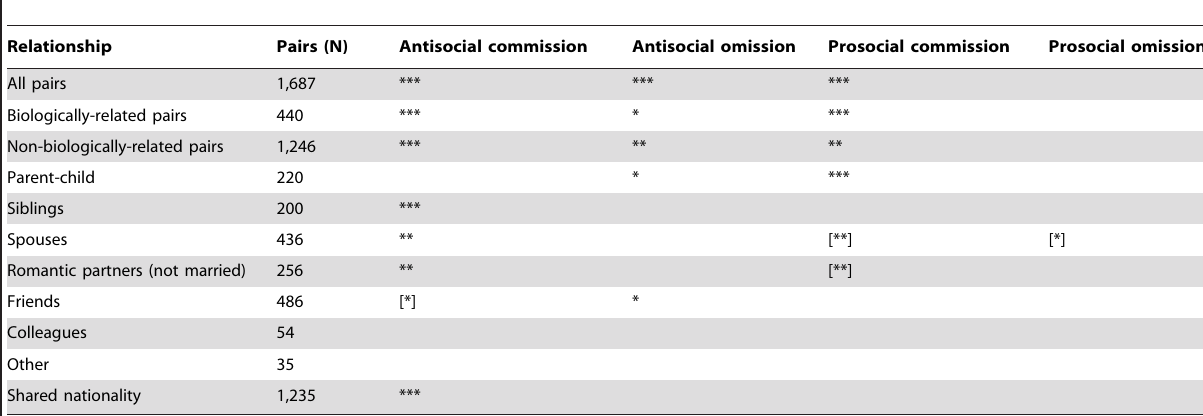
Table 4. Summary of Subscale Relatedness across Different Participant Pair Relationships.